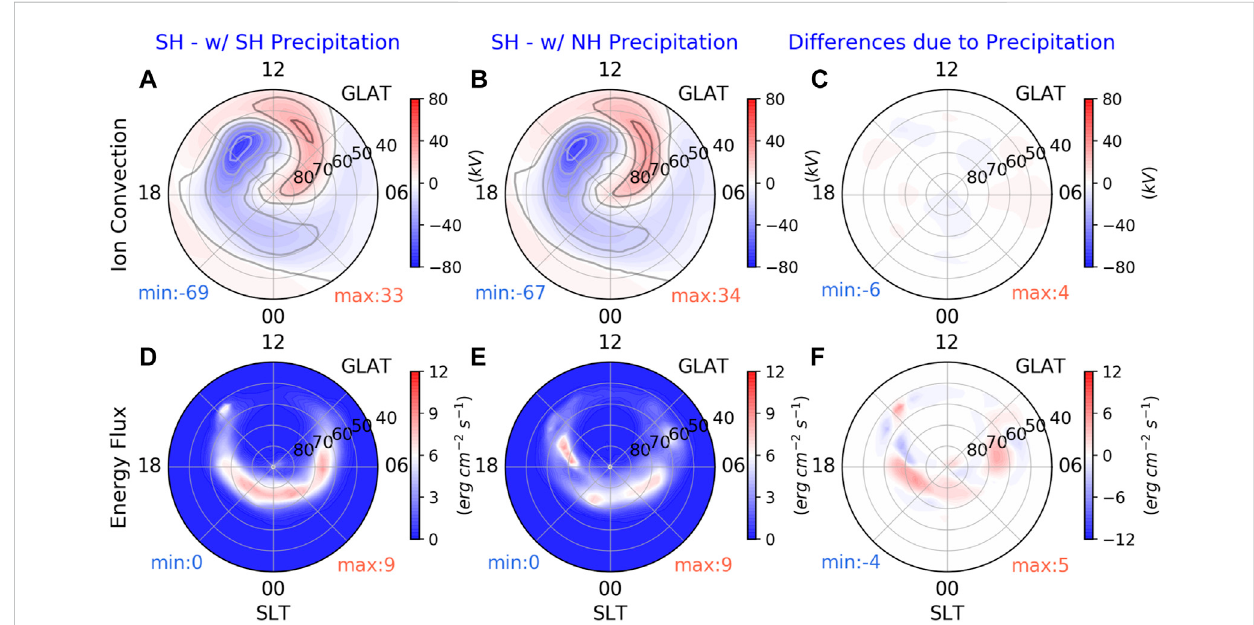
FIGURE 8 Snapshots of the FAC-driven convection patterns (top)for the Southern Hemisphere (SH) driven by different AMIE electron precipitation patterns at 04 UT on October 9 as an example: the SH precipitation itself (A) , mirrored precipitation pattern in the geomagnetic fi eld coordinate from the Northern hemisphere(NH, (B) ,andtheirdifference (C) .Thecorrespondingenergy fl uxoftheprecipitationpatternsfortheSH (D) ,NH (E) ,andtheirdifference (F) are shown in the